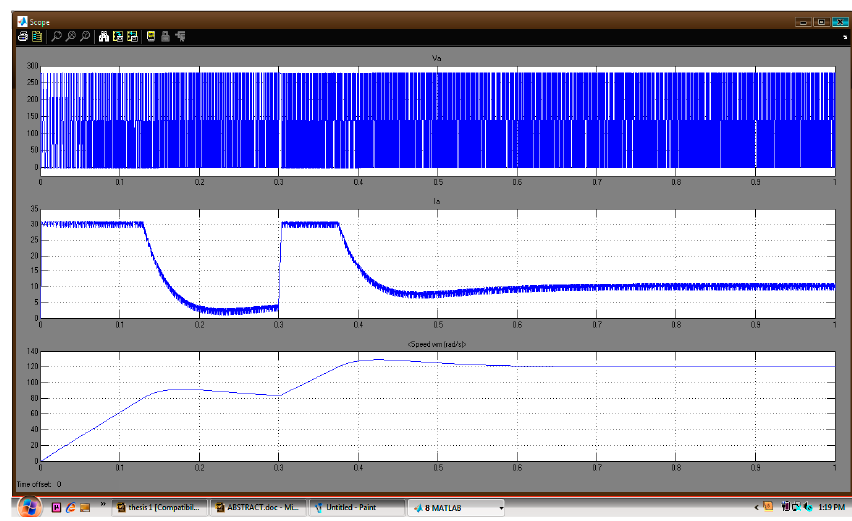
Figure 15. Simulation results of PID controller for the speed of 80 rad/s and final 120 rad/s.